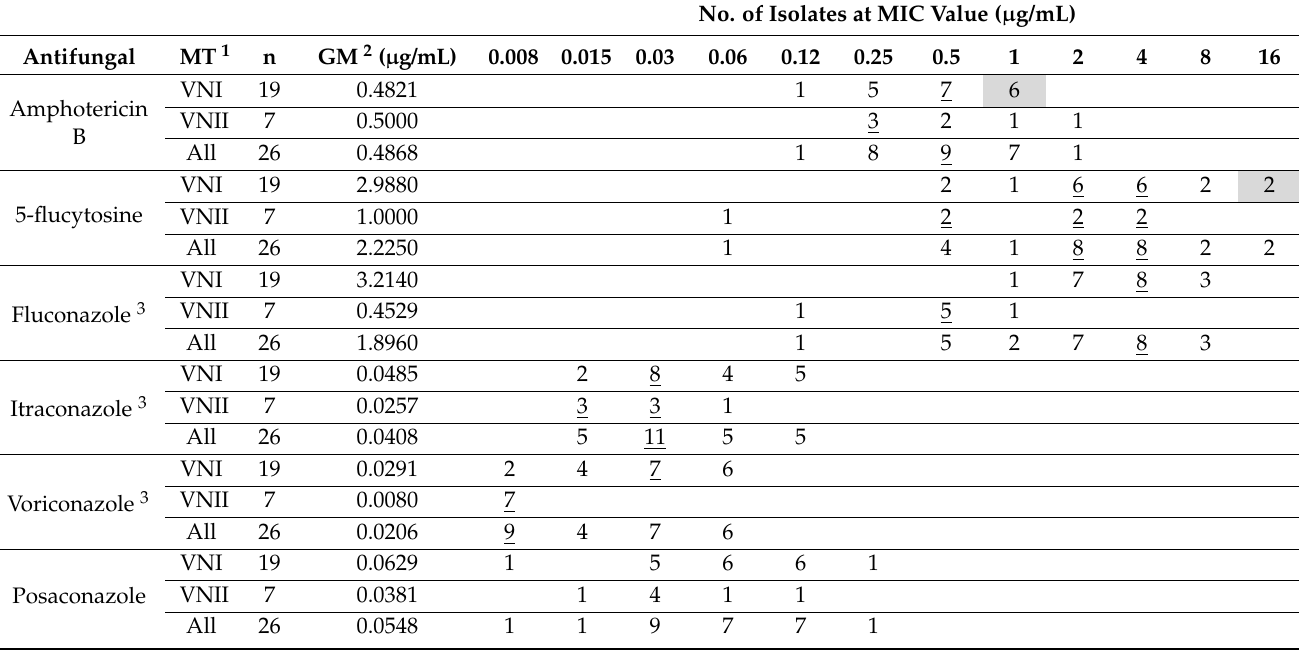
Table 3. Distribution of the minimal inhibitory concentrations (MIC) of clinical Cryptococcus neofor- mans isolates from Peru. Modes are underlined. Non-wild-type isolates, which were determined with results obtained with the Clinical and Laboratory Standards Institute method, as referenced elsewhere [29,30], are